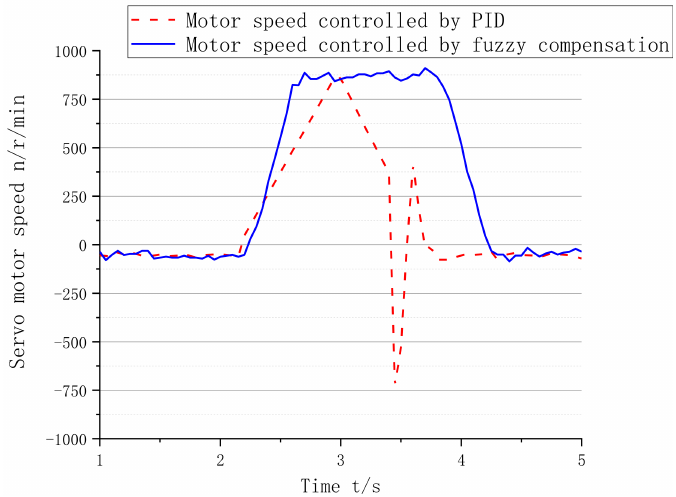
Figure 10. Speed response curve of the servo